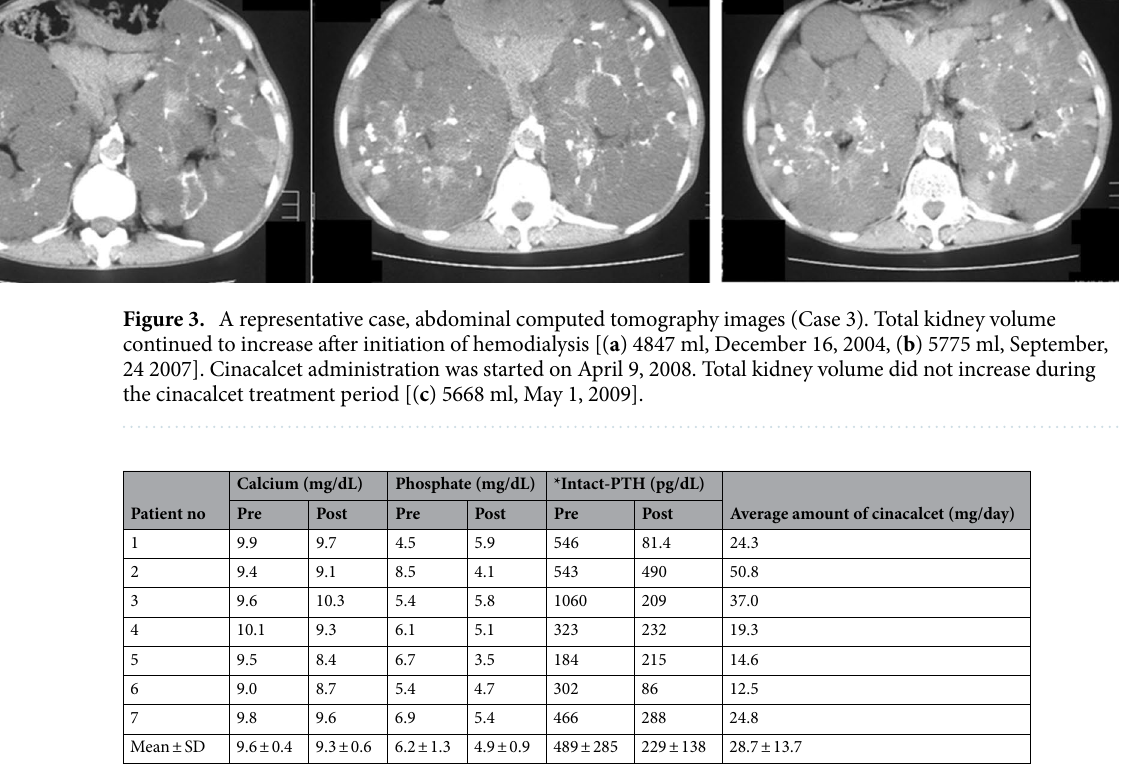
Table 4. Changes in serum calcium, phosphate, and intact-PTH levels, and total kidney volume before and after cinacalcet treatment in hemodialysis patients with autosomal dominant polycystic kidney disease,